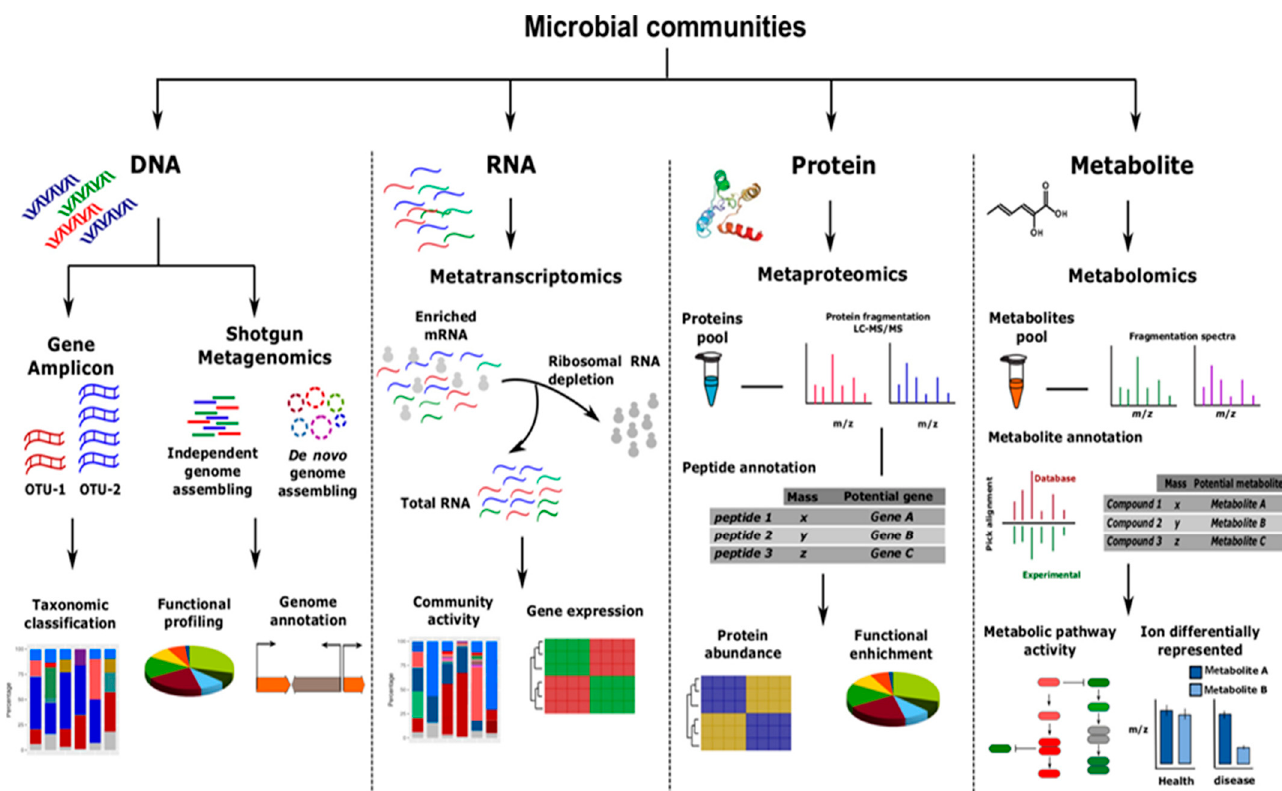
Figure 6. Omics techniques for the construction of an efficient consortium. Different experimental and computational methods can be applied on co-cultured cells to reach a deep knowledge and characterization of the microbial communities. Reprinted with permission from Zuñiga et al. (2017). Elucidation of complexity and prediction of interactions in microbial communities. Microbial biotechnology [119]. Copyright (2017), Wiley.